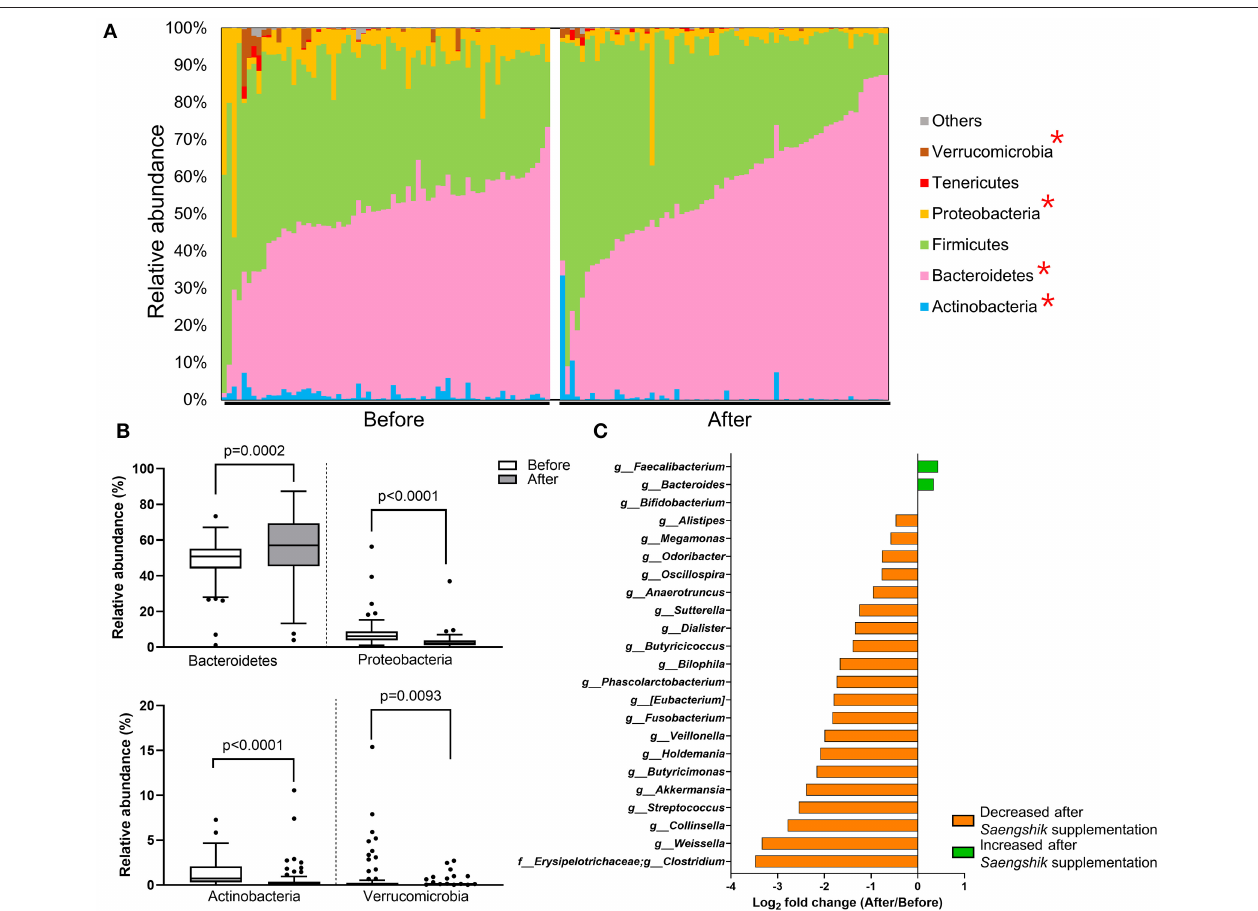
FIGURE 3 | The relative abundance of bacterial taxa is affected by Saengshik intervention. (A) Distribution of gut microbial phyla before ( n = 66) and after ( n = 66) intervention. Each bar represents an individual participant. The proportion of the various taxa in each phylum is presented as a percentage of relative abundance with respect to total bacterial sequences. Different color schemes represent different phyla (blue: Actinobacteria, pink: Bacteroidetes, green: Firmicutes, yellow: Proteobacteria, red: Tenericutes, brown: Verrucomicrobia, gray: others). (B) Differences in the mean relative abundance of phyla before ( n = 66) and after ( n = 66) intervention. Tukey’s box-and-whisker plots show the median (horizontal line) and interquartile range (IQR) (box), with additional data within 1.5 IQR shown as whiskers. The white and gray box plots represent the mean relative abundance of phyla before and after the intervention, respectively. (C) List of significantly changed genera according to genera found before ( n = 66) and after ( n = 66) intervention. Box plots of relative abundance show the fold change after vs. before intervention on the log 2 scale. P < 0.01, Wilcoxon signed-rank test. The green and orange bars represent the bacterial genera that increased and decreased in abundance after Saengshik consumption,